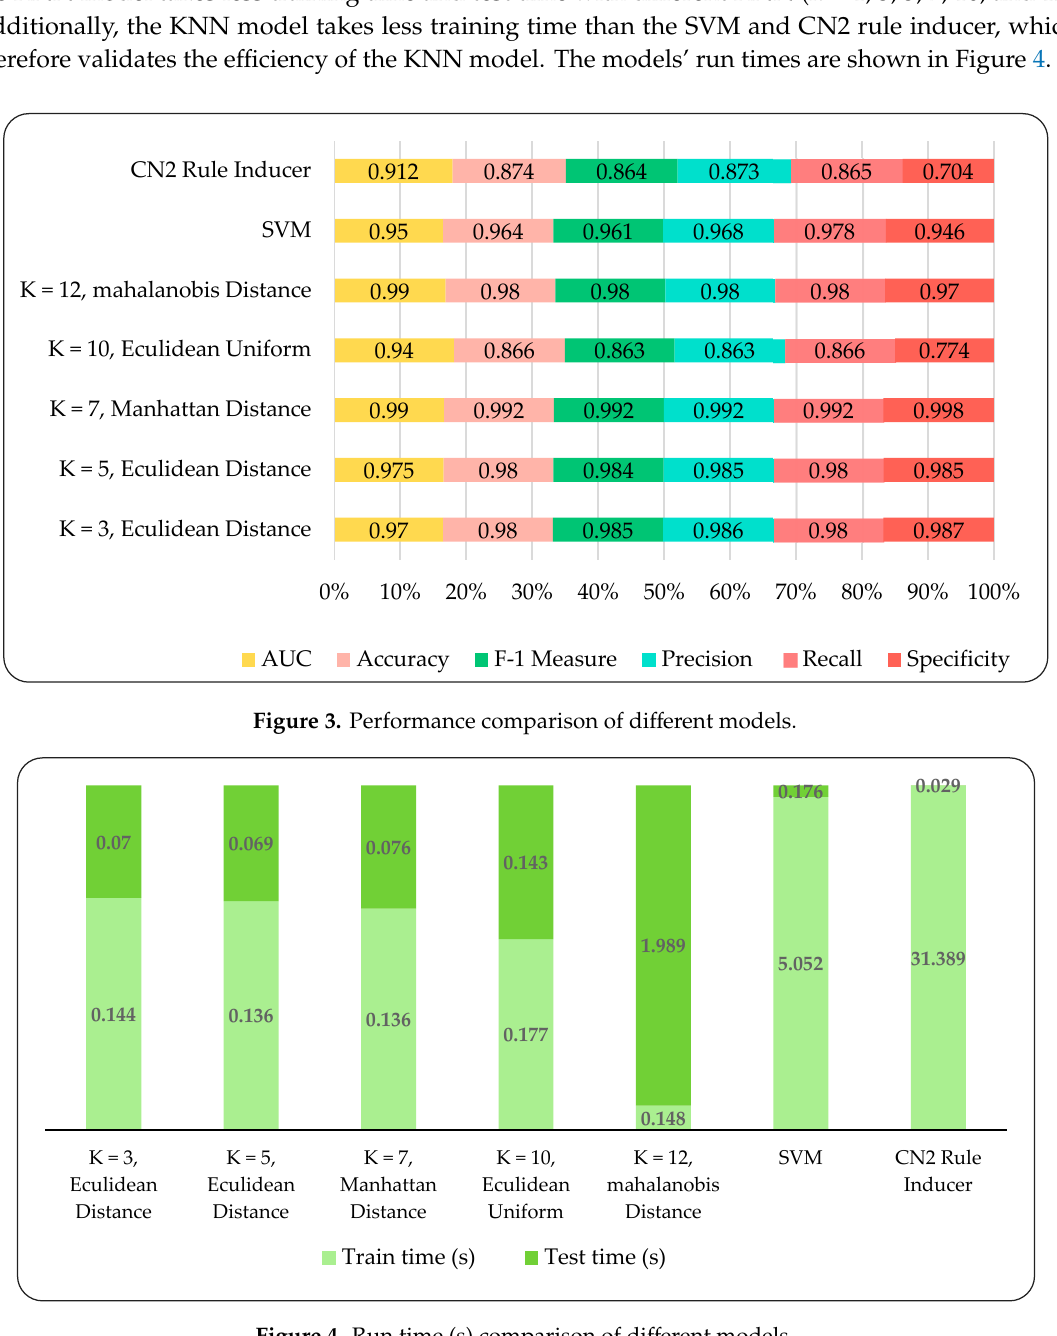
Figure 4. Run time (s) comparison of different models.